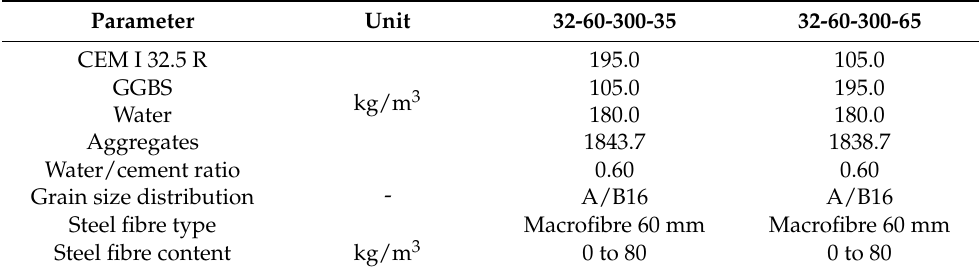
Table A4. Concrete mix designs for the variation of the content of